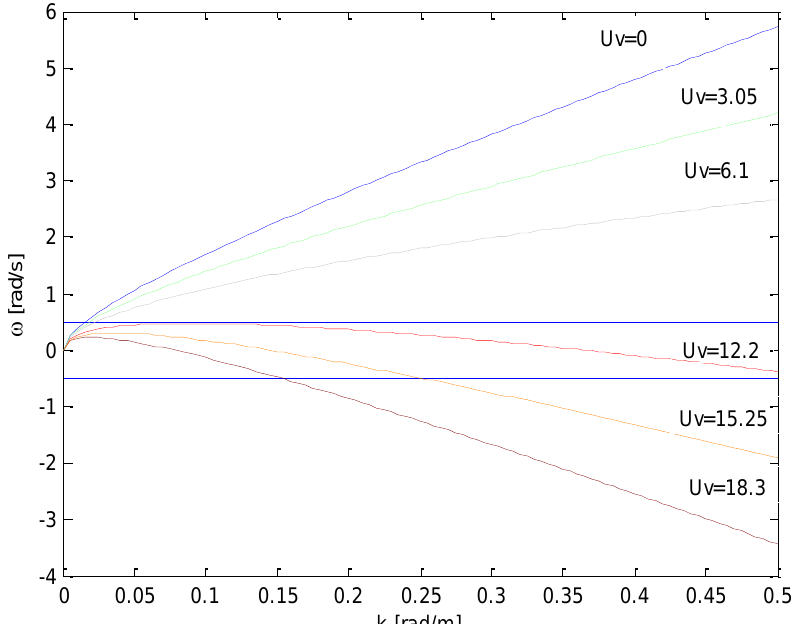
)~ ,(~ Uk  (according to Equation(14)) for a fixed value of the Figure 6. Behaviour of surface current 7U  m/s and for different values of the virtual surface current   18.3 15.25, 12.2, 6.1, 0,3.05,U  v